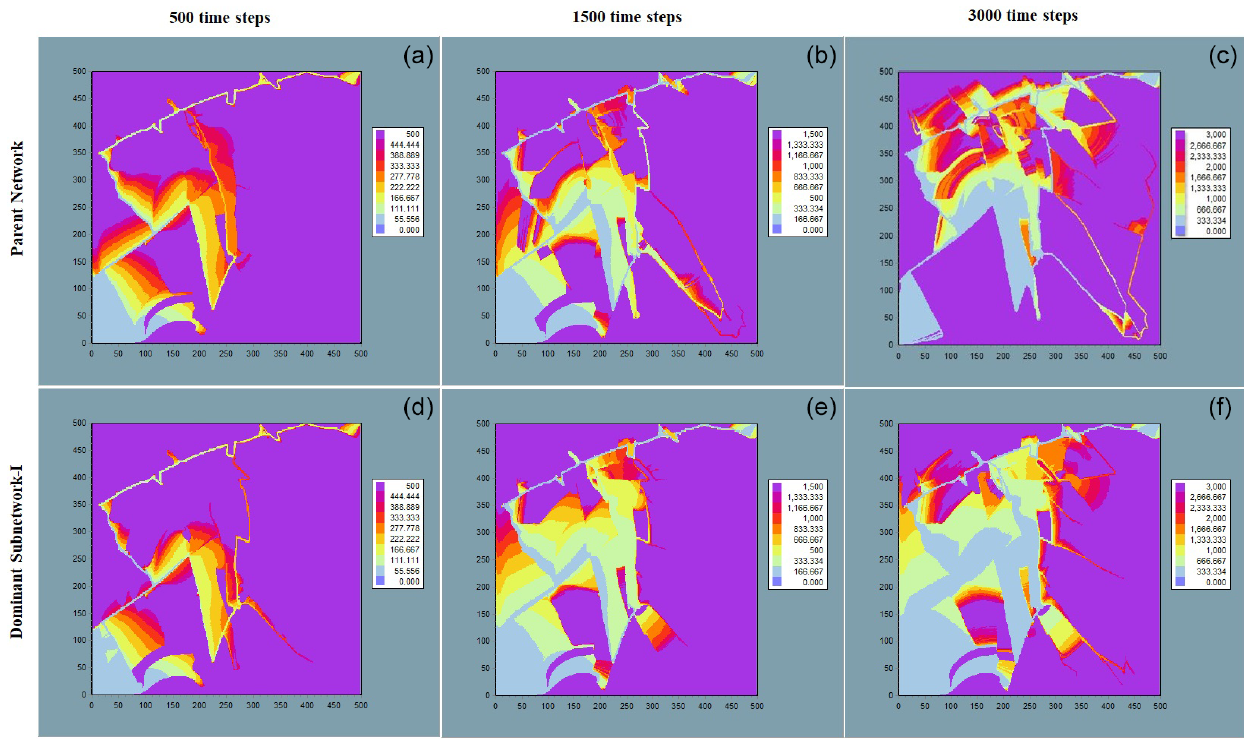
Figure 10. TOFs at different time steps (500, 1500 and 3000) of natural fracture map (a–c) and its dominant sub-network (d–f)